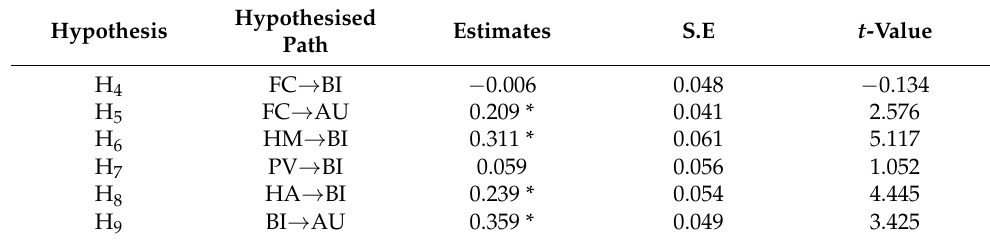
Table 4. Relationship of students’ behavioural intention to use smart technologies in blended learn- ing.